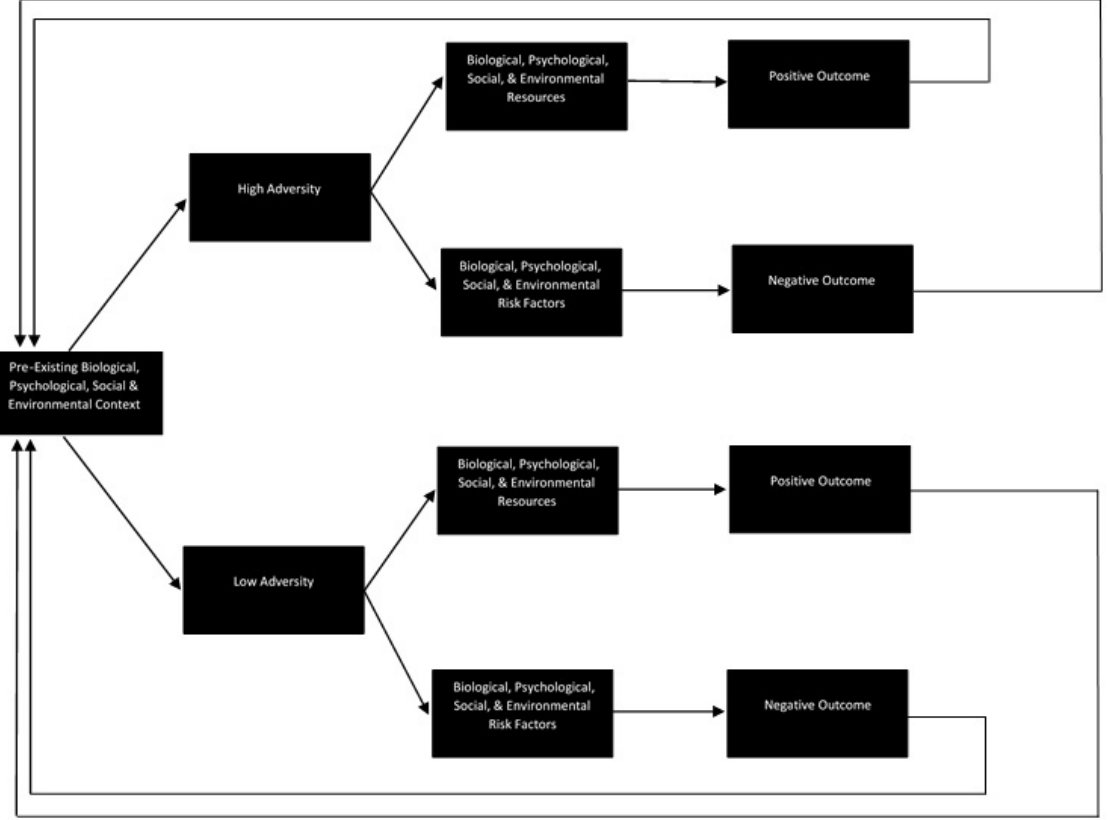
Figure 1. A proposed model of resilience in family carers of people with dementia.